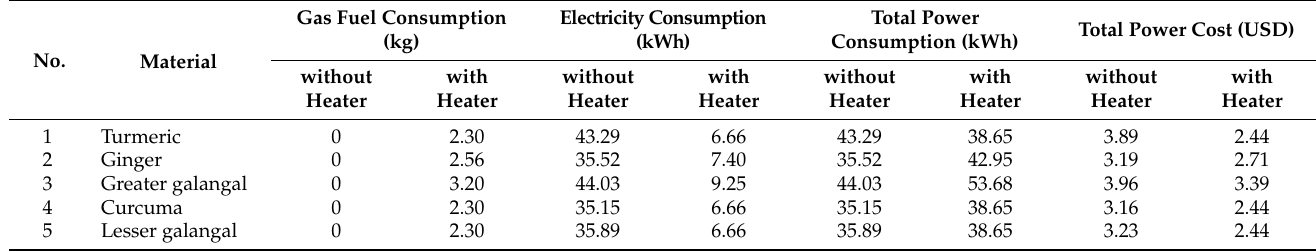
Table 8. Energy consumption of Polydryer with and without the employment of a